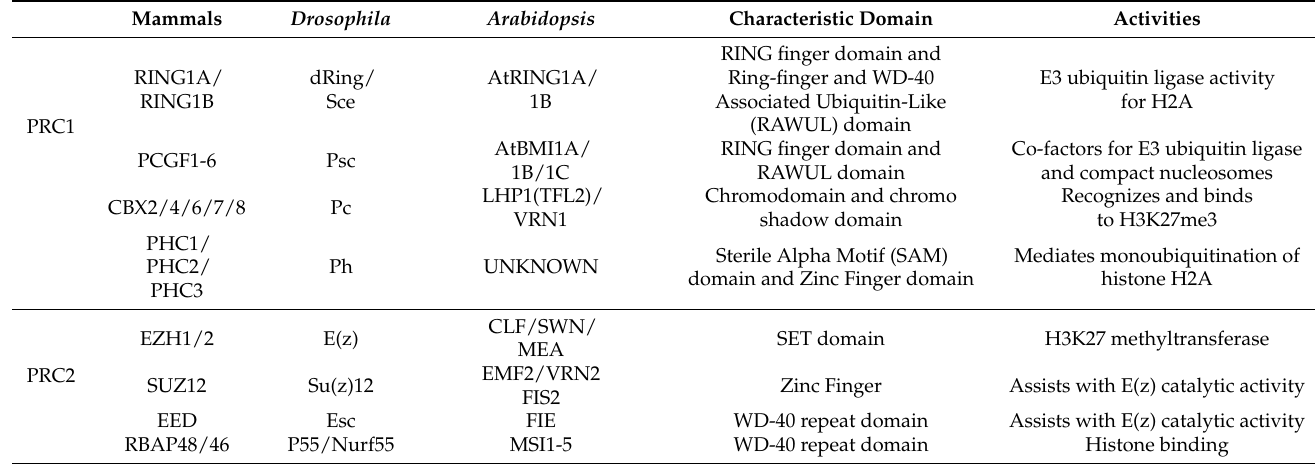
Table 1. Core subunits of PRC1 and PRC2 in different